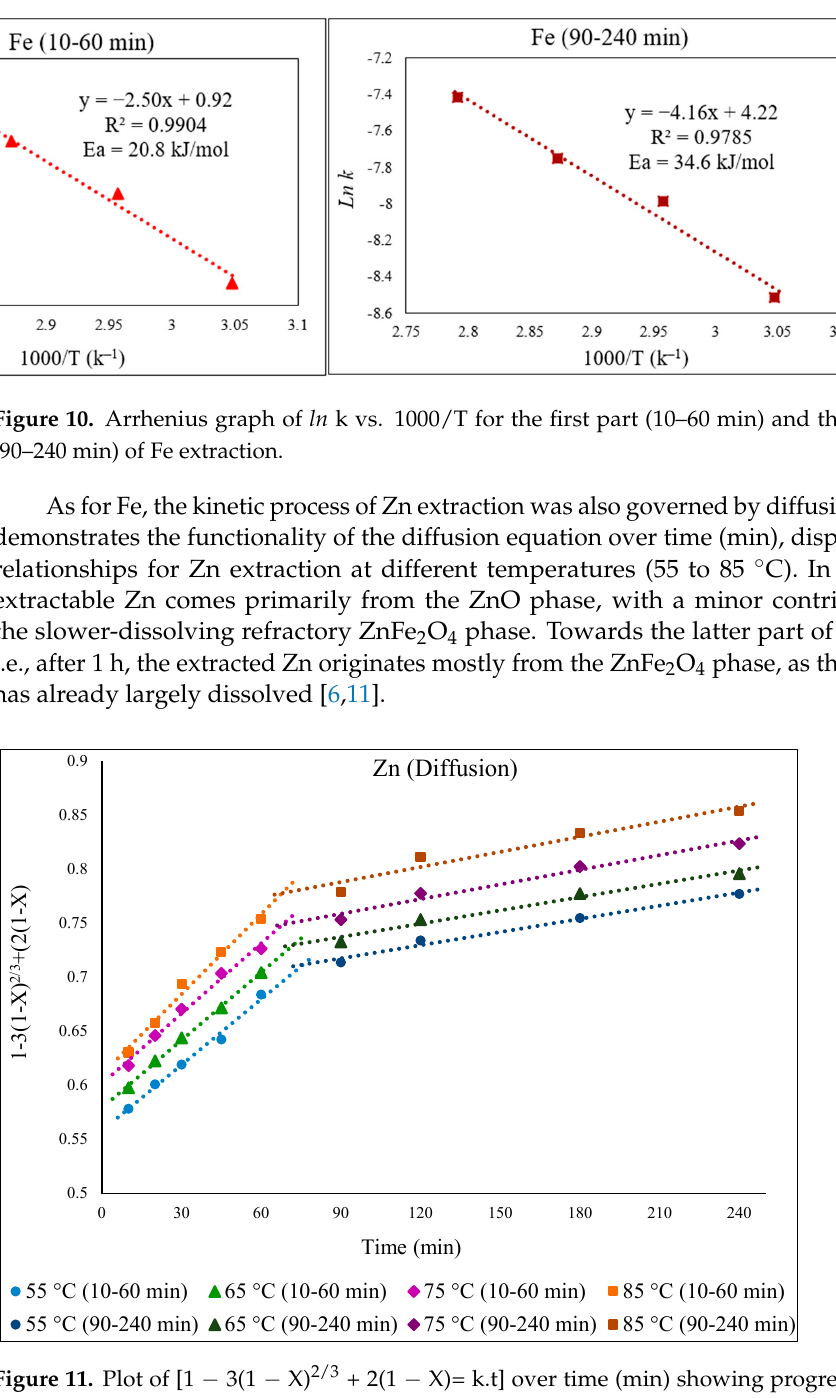
Figure 11. Plot of [1 − 3(1 − X) 2/3 + 2(1 − X)= k.t] over time (min) showing progress at different temperatures of 55–85 °C for the dissolution of Zn from EAFD in 30% v/v [Bmim + HSO 4 − ] solution with 1 g of oxidant Fe 2 (SO 4 ) 3 .